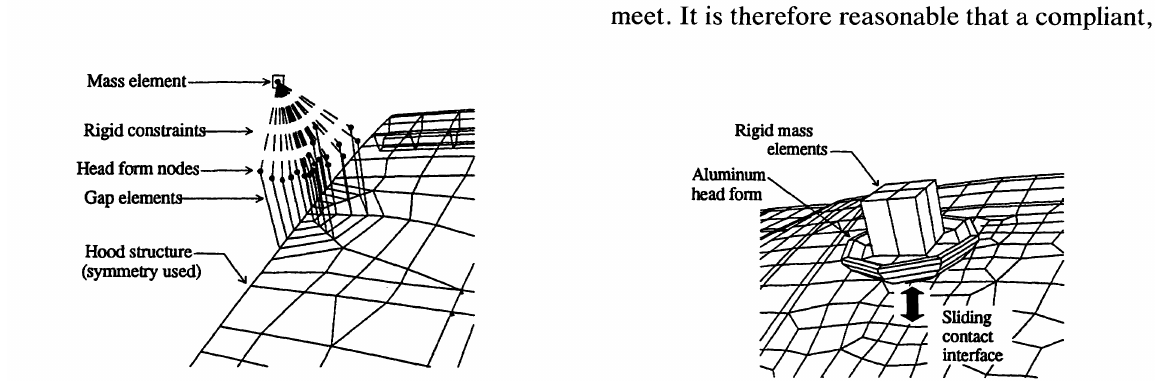
FIGURE 1 ANSYS Ciera hood model: head form representation.